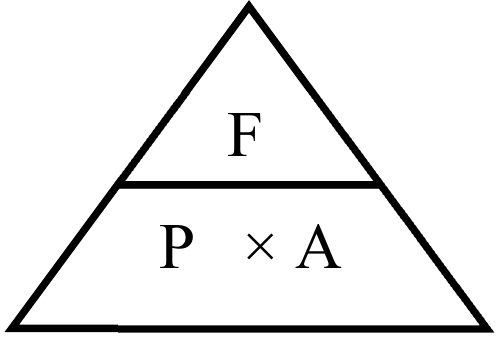
Figure 2. Tool to help students remember how to do subject of the formula for pressure in solids.